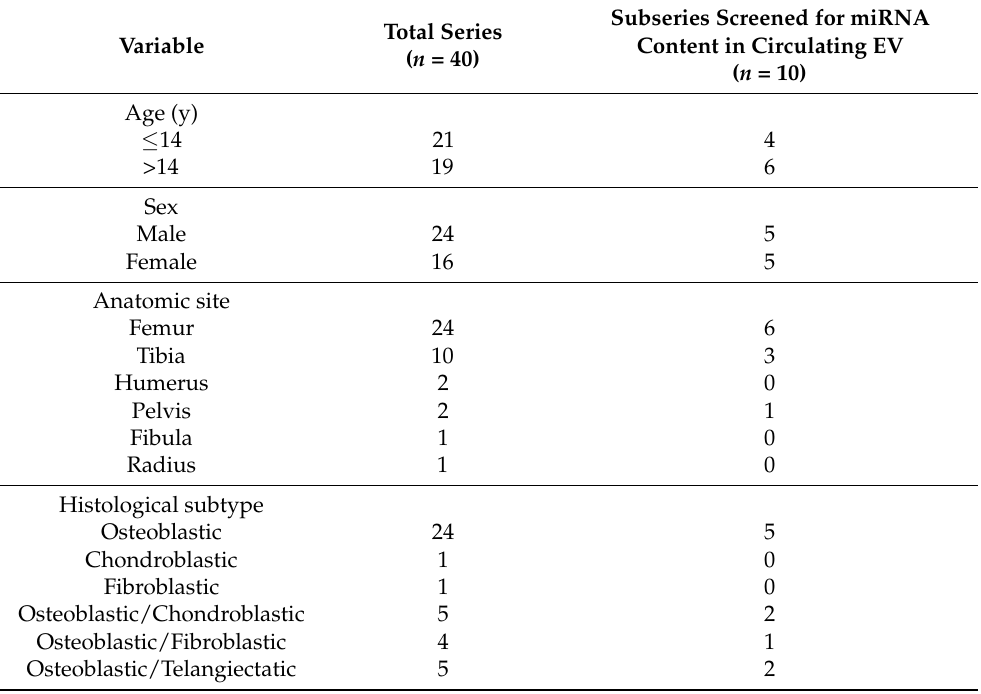
Table 1. Clinical and pathological features of OS